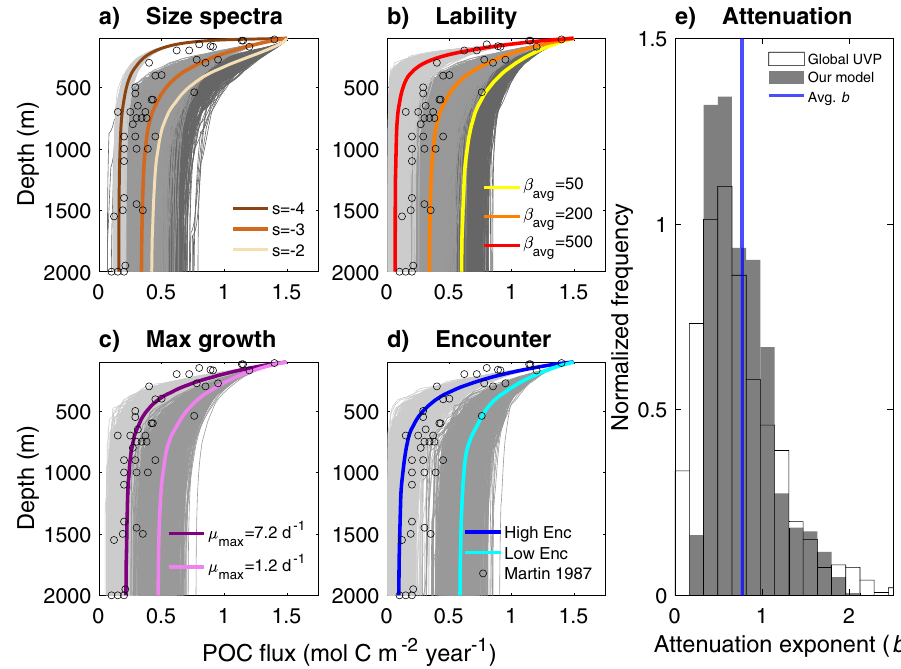
Fig. 4 Microbial contribution to large-scale particulate organic carbon (POC) fl uxes. Shifts in POC fl uxes over depth are shown as a function of varying particle and microbial dynamics. Each gray line is the integrated fl ux over 2,256 to 763,615 stochastically initialized particles (depending on the particle size spectra). For each parameter set, 1,000 stochastic simulations were conducted (1,000 gray lines of different shades). The average for each parameter set is shown with the thick colored line. The data from Martin et al (1987) (in open circles) are also shown. POC transfer ef fi ciency decreases (larger attenuation exponent b ) with more negative particle size spectra power law exponent s ( a ), higher mean particle lability ( β , mmol C poc mmol C cell − 1 day − 1 ) ( b ), higher avg maximal growth rate ( μ max , day − 1 ) ( c ), and higher particle-microbe encounter rate (Enc) ( d ). The distribution of attenuation exponent ( b ) for all 10,000 stochastic simulations from panels a-d (gray bars) are compared against observed attenuation coef fi cients from 897 global Underwater Video Pro fi ler (UVP) measurements compiled by Guidi et al. (2015) (open bars) ( e